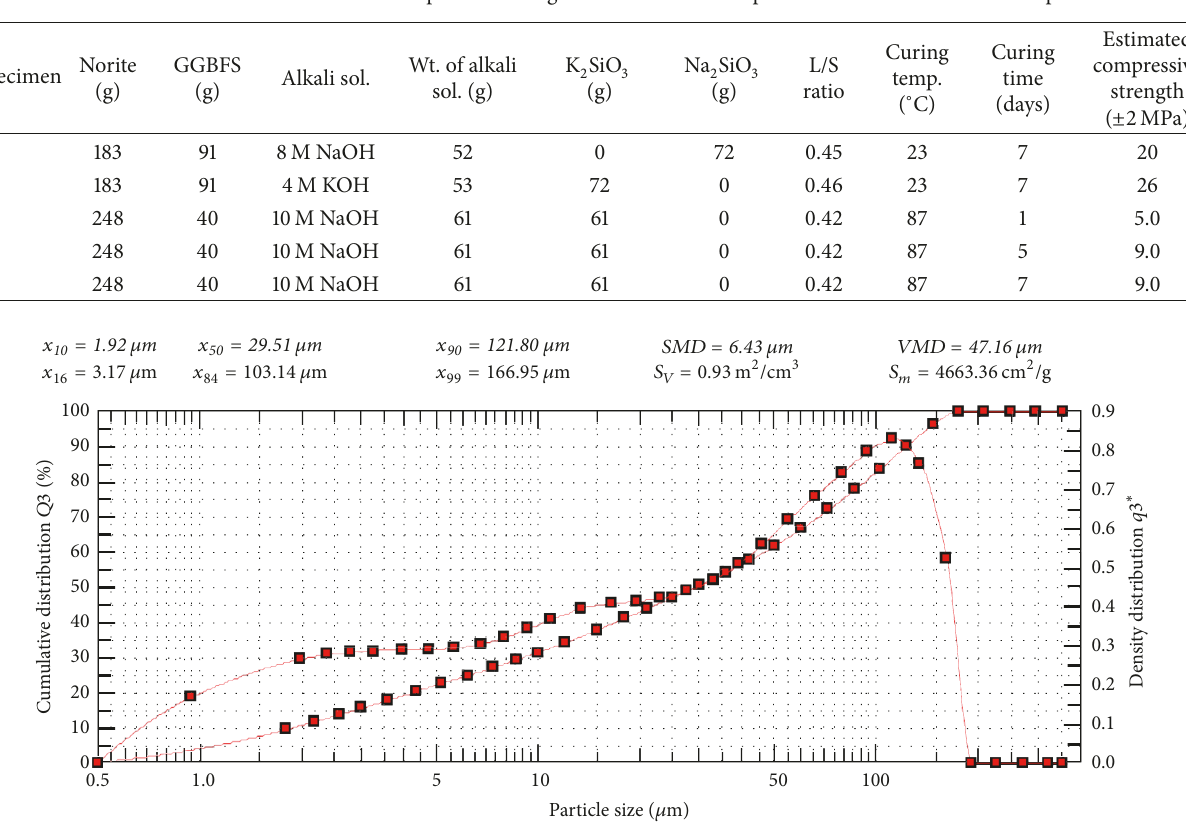
Figure 1: Graphical representation of particle size distribution analysis of the analyzed